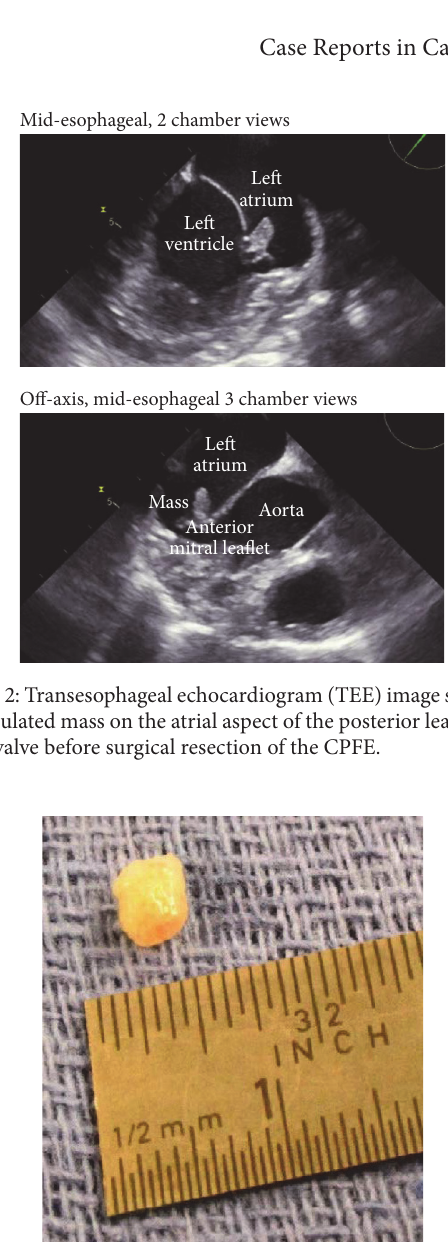
Figure 3: Surgical resection of the cardiac